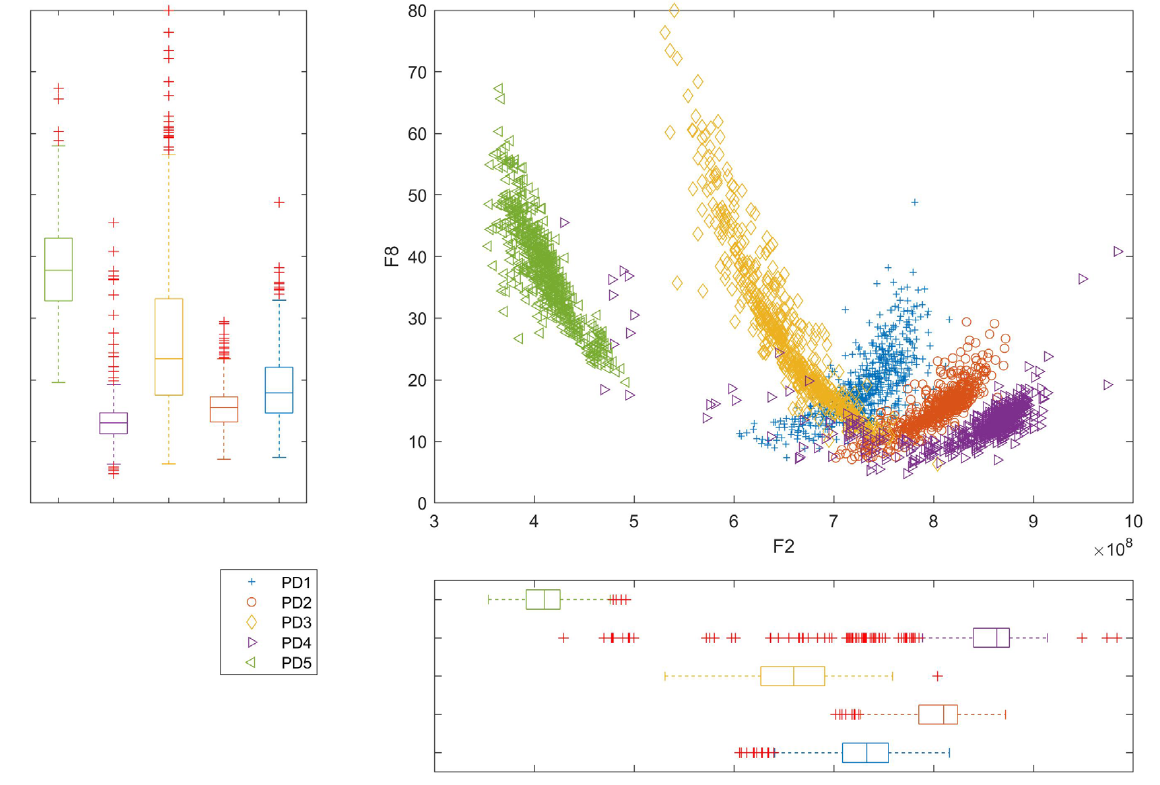
Figure 5. Example scatter plot of the F8 versus F2 features along with box plots for data acquired from antenna A1, showing clearly distributed clusters and significant correlation of F8 vs. F2.